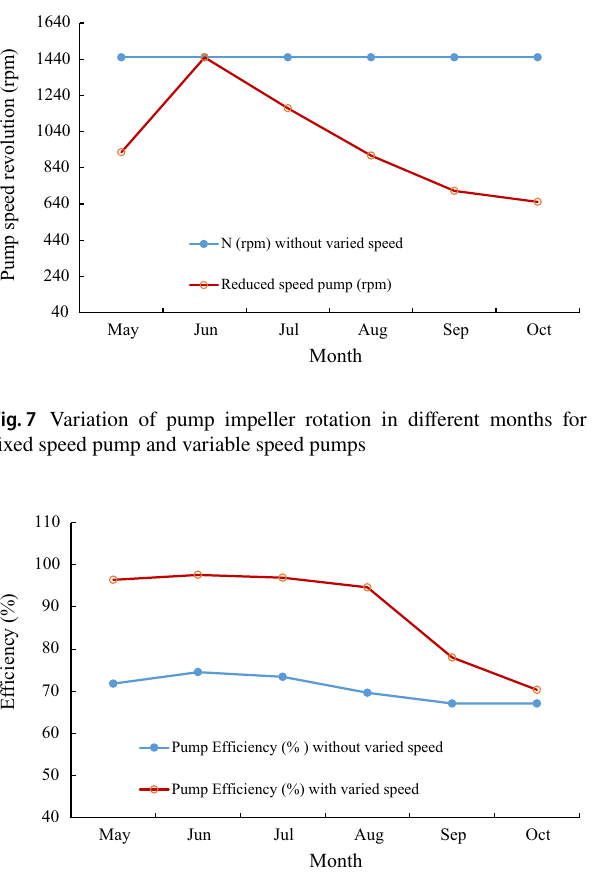
Fig. 8 Variation of pump efficiency in different months for two modes of fixed speed pump and variable speed